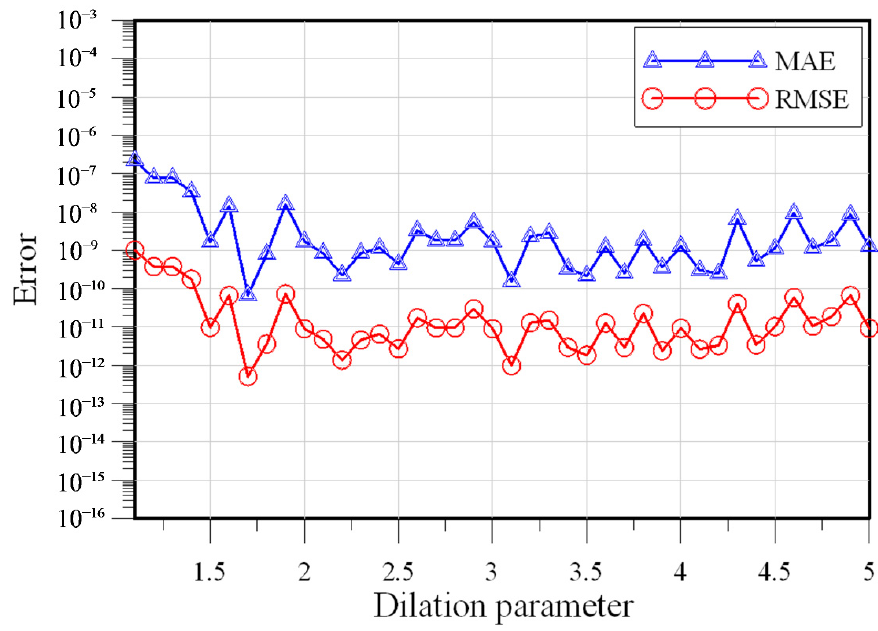
Figure 4. Error versus the dilation parameter.